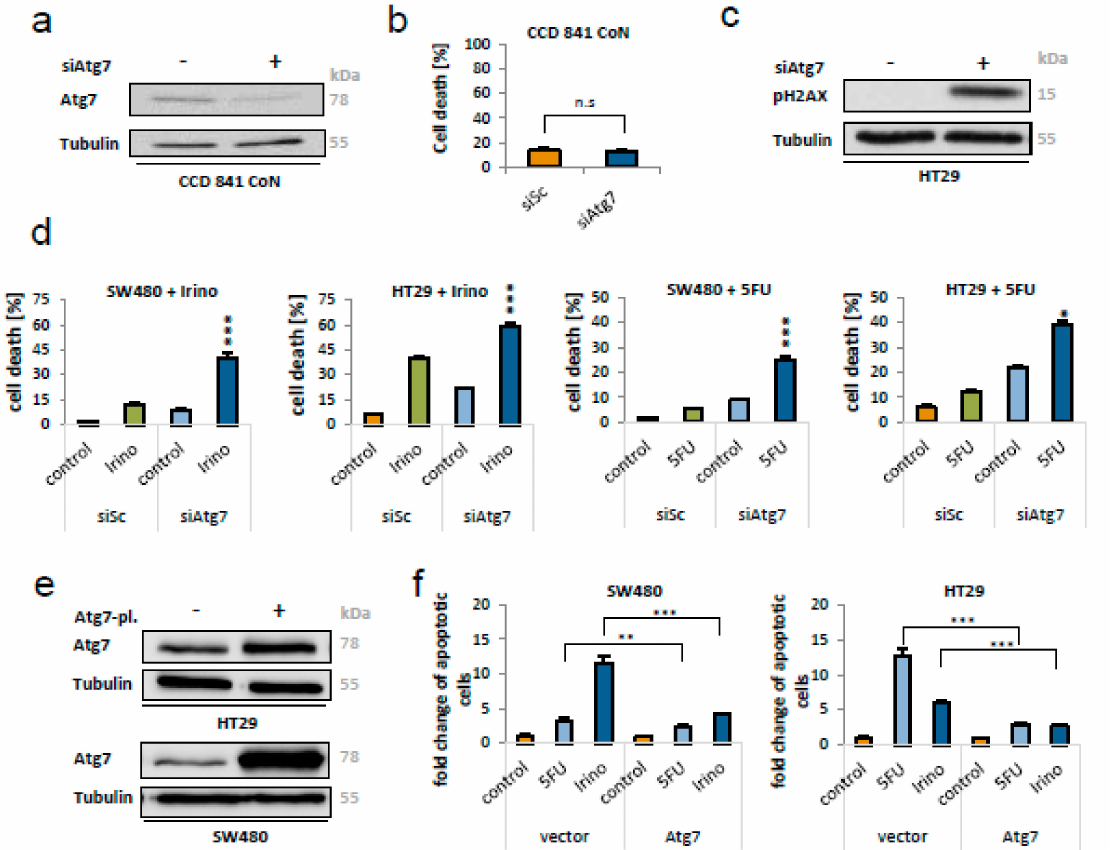
Figure 6. Knockdown of Atg7 led to cancer cell specific apoptosis and augmented chemotherapy in colorectal cancer cells. ( a ) Immunobloting of normal intestinal epithelial cells (CCD 841 CoN) 48 h after siRNA (80 nM) mediated knockdown of Atg7. ( b ) Corresponding FACS analysis, indicating no apoptosis in CCD 841 CoN cells after disruption of Atg7 via siRNA. ( c ) Immunoblotting of pH2AX, indicating DNA damage in HT29 cells after knockdown of Atg7 (80 nM; 24 h). ( d ) Flow cytometry for DNA fragmentation indicating apoptosis after transfection with 80 nM of siAtg7 (#1 for SW480 and #2 for HT29), treatment with 5-FU (5 µ g / mL for SW480 and 2 µ g / mL for HT29) or the combination of both for 48 h; or the same setting with Irinotecan (5 µ M for SW480 and 10 µ M for HT29) for 48 h. p -values for the interaction indicating a synergistic e ff ect are based on two-way ANOVA; * = p < 0.05, *** = p < 0.001. Data represent mean + SD of independent biological triplicates. ( e ) Immunoblotting of HT29 and SW480 cells 48 h post-transfection with a plasmid expressing Atg7. ( f ) Quantification of cell death in SW480 (left) and HT29 cells (right), measured by flow cytometry 48 h after transfection with a plasmid expressing Atg7, treatment with either 5-FU (50 µ g / mL) or Irinotecan (25 µ M) or a combination thereof. ** = p < 0.01, *** = p <